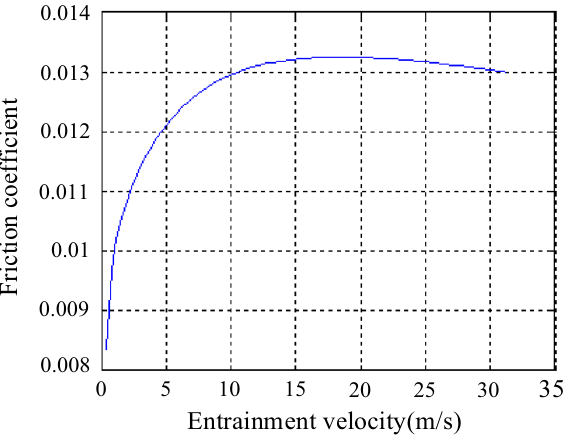
Fig. 7 Influence of entrainment velocity on friction